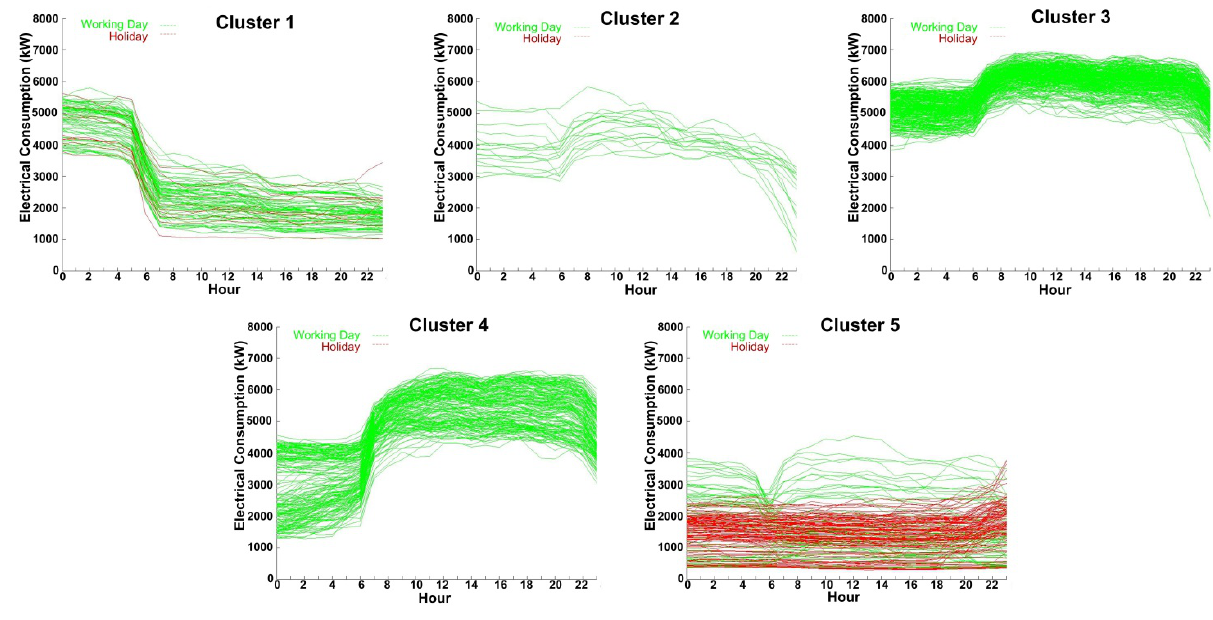
Figure 8. Load curves for the five clusters, red curves are from holidays, and green days are working days.